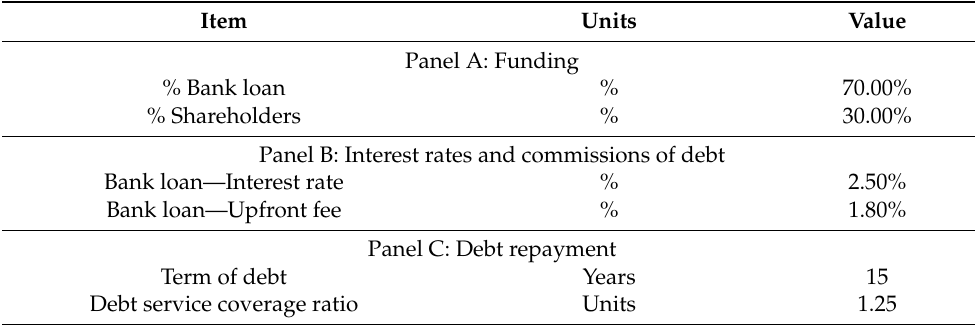
Table 2. Financial